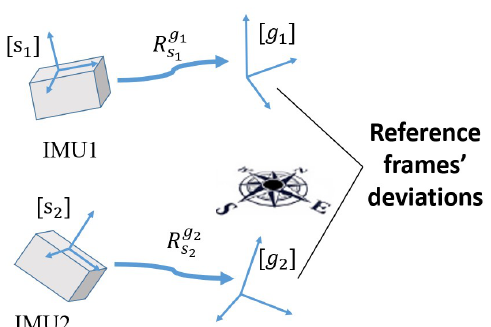
Figure 1. The schematic figure of reference frame unification, where R g i s from the sensor-fixed frame [ s i ] to the reference frame [ g i ] .